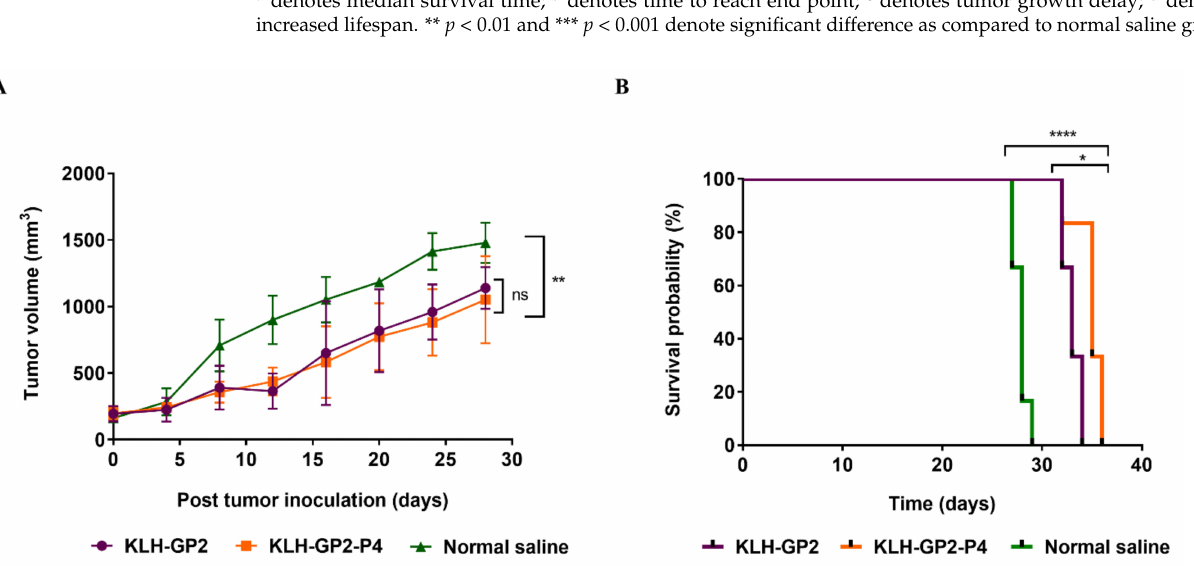
Figure 7. Therapeutic effects of tested vaccine candidates against the TUBO tumor in the BALB/c mice model. The mice ( n = 6) received three doses of vaccines in two weeks intervals upon tumor establishment. ( A ) Changes in tumor growth and ( B ) the survival time frame of mice. The data indicate the mean ± SEM. **** p < 0.0001, ** p < 0.01 and * p < 0.05 denote significant difference as compared to normal saline